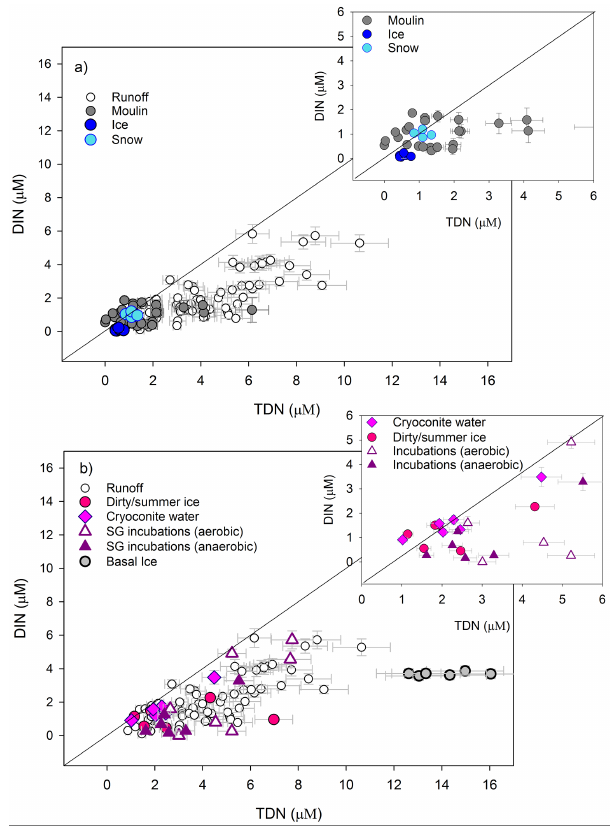
Figure 3. Associations between TDN and DIN in (a) runoff, moulin waters, snow and pre-melt ice, where data on snow and pre-melt ice are from Wolff (2013) and Telling et al. (2012) and (b) runoff and glacier surface ecosystems (cryoconite holes, summer ice including dispersed debris) and subglacial ecosystems (basal ice and meltwa- ter sampled from anaerobic/aerobic long-term subglacial (SG) in- cubation experiments). A line indicates ratios of 1 for TDN/DIN where the TDN content of samples is entirely comprised of DIN. Samples that plot below this line have a dissolved organic nitrogen component. All samples have been blank-corrected, and error bars reflect the uncertainty of nutrient analyses given known precision and accuracy.